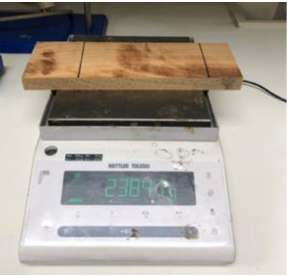
Figure 1. Oak sample in the process of applying protective